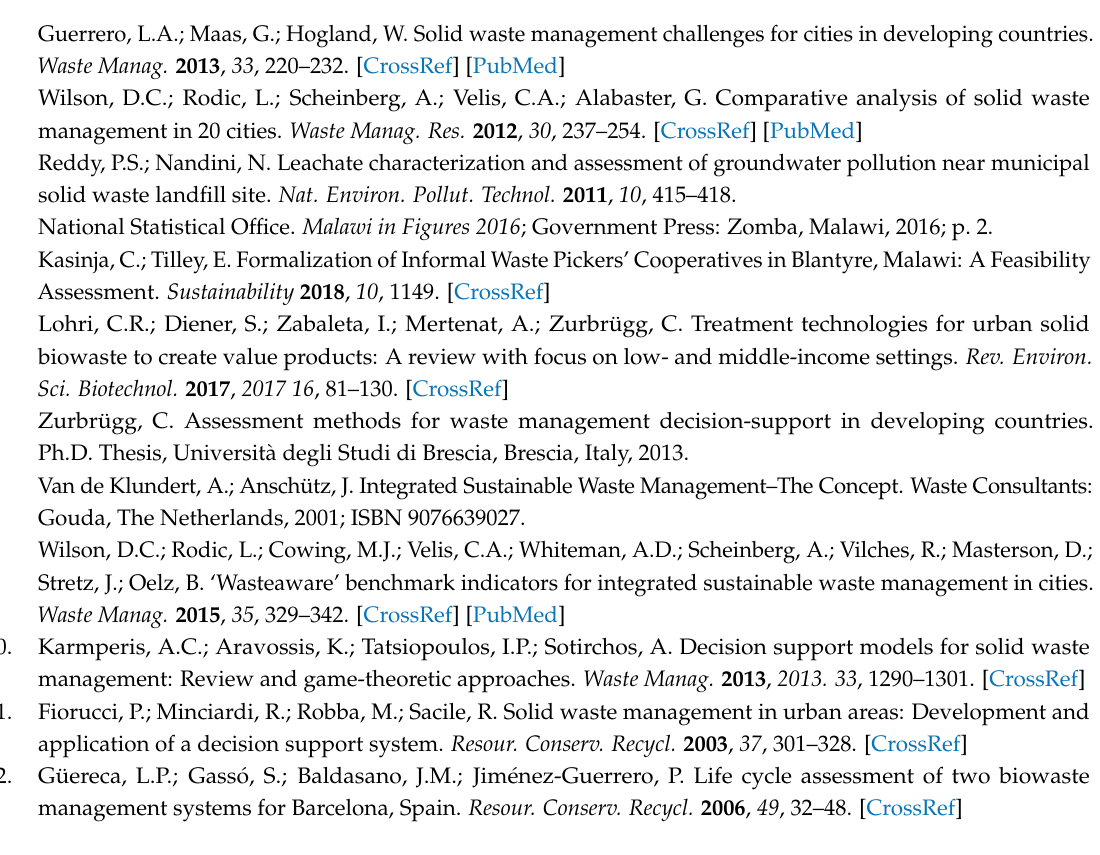
Table S1: The Swing Questionnaire: points given to each scenario were used in the calculation of the stakeholder’s preference weight for the objective pointed by an arrow in the respective scenario; Table S2: The Reverse Swing Questionnaire: points given to each scenario were used in the calculation of the stakeholder’s preference weight for the objective pointed by an arrow in the respective